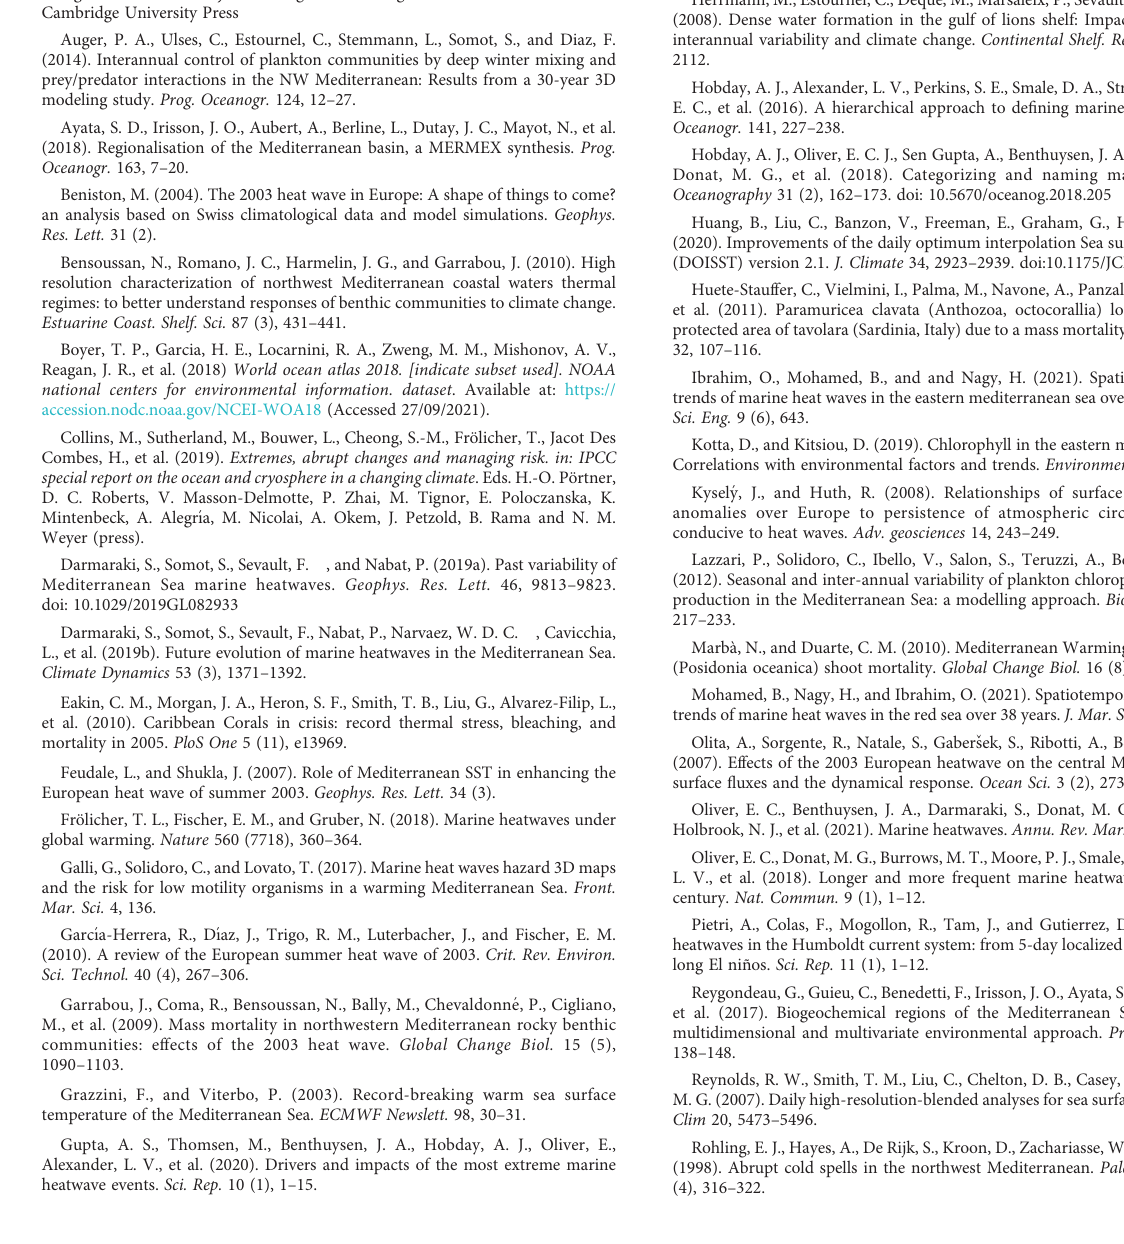
SUPPLEMENTARY FIGURE 4 Same as Figure S2 but in the eastern Mediterranean. SUPPLEMENTARY FIGURE 6 Same as Figure S2 but for winter (DJFM) MCSs. SUPPLEMENTARY FIGURE 7 Times series of the discrete maximum mean intensity (in °C) in the Mediterranean (magenta line), the western Mediterranean (orange line)